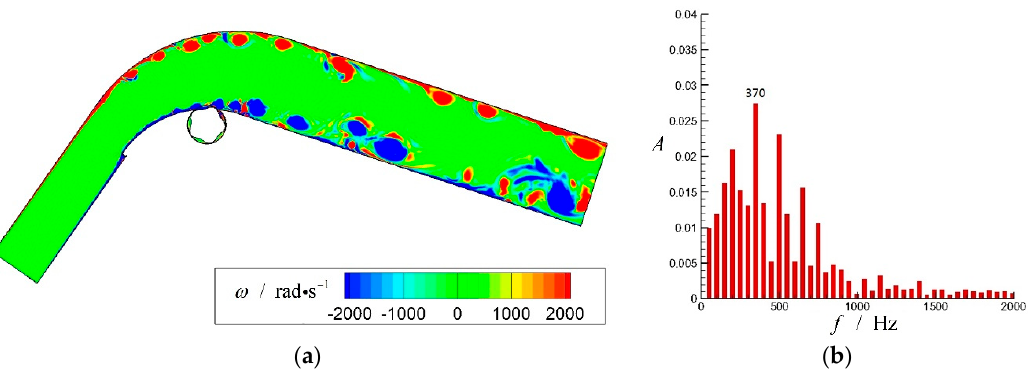
Figure 7. Numerical simulation of the diffuser without control ( (cid:101) V = 0, (cid:101) f = 0, and f TWW = 0): ( a ) Vorticity ( ω ) contour; ( b ) Velocity FFT of S2 ( A − f ).